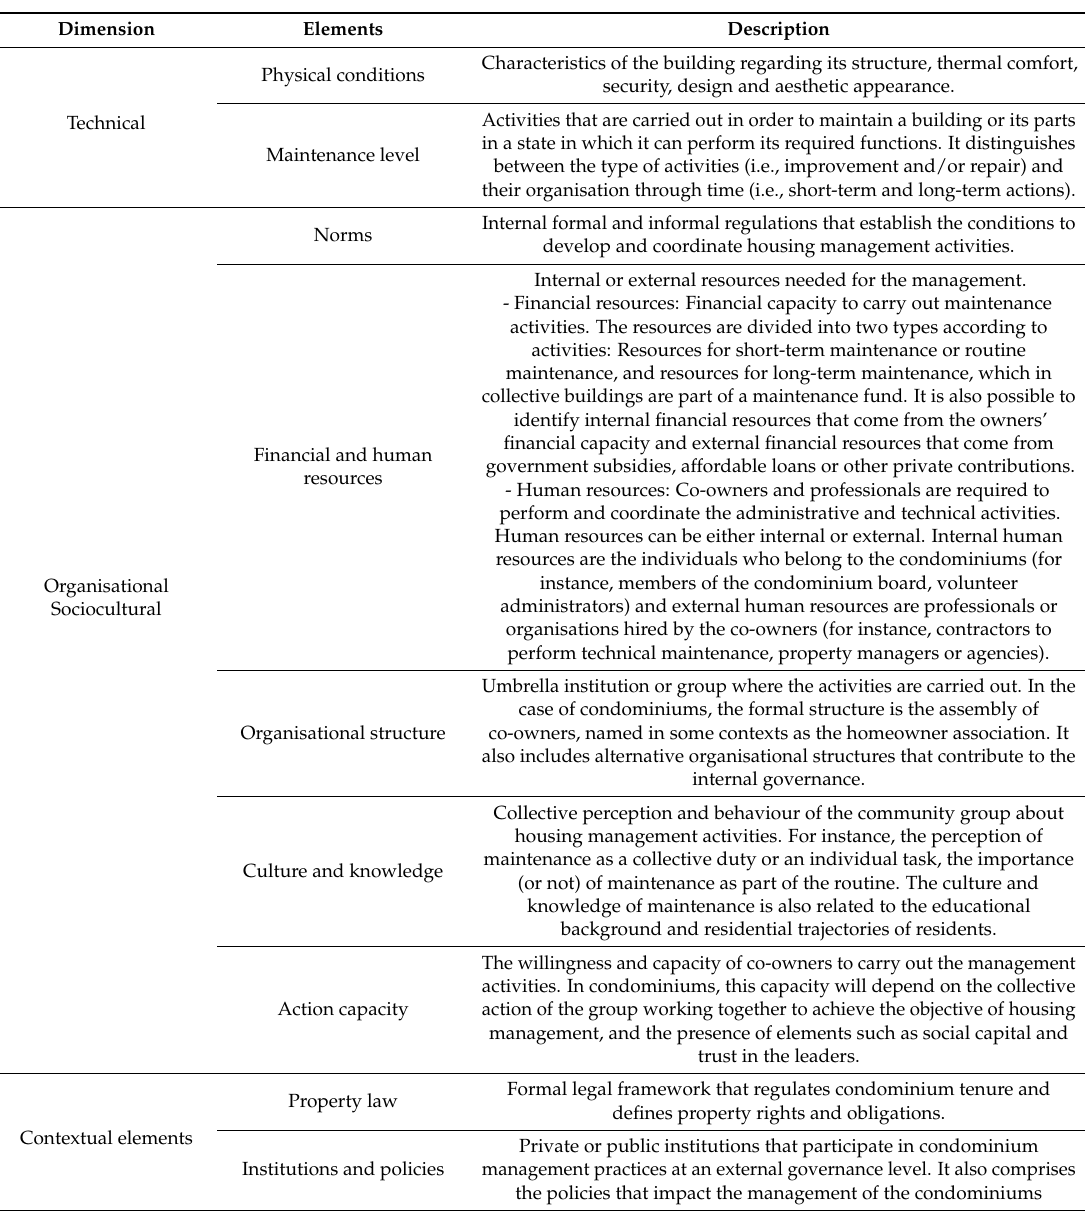
Table 2. Condominium management dimensions and